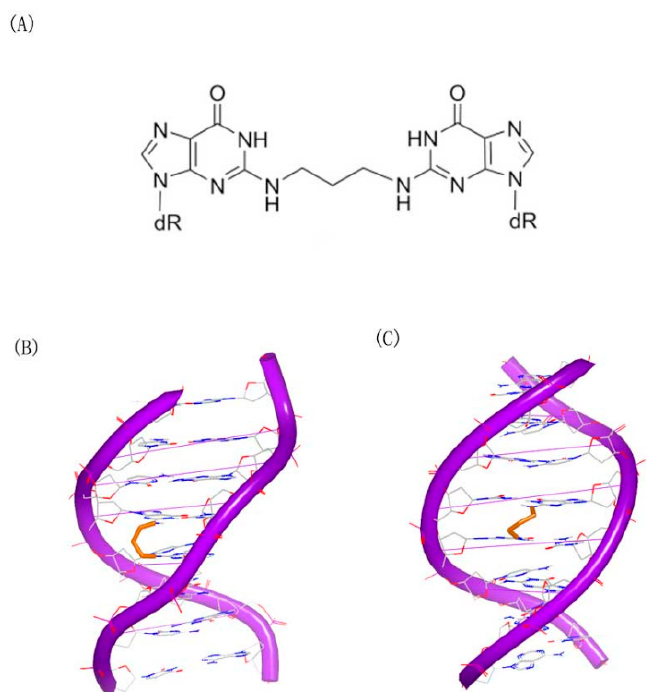
Figure 4. ( A ) Chemical structure of N 2 G–trimethylene–N 2 G; ( B ) crystal complex of a DNA with N 2 G–trimethylene–N 2 G cross-link (PDB code: 2KNK); and ( C ) crystal complex of a DNA with N 2 G–trimethylene–N 2 G cross-link (PDB code: 2KNL). The orange structure represents the small molecule; the purple structure represents the backbone of nucleic acid; the blue and red atoms in the molecule represent nitrogen and oxygen atoms, respectively.